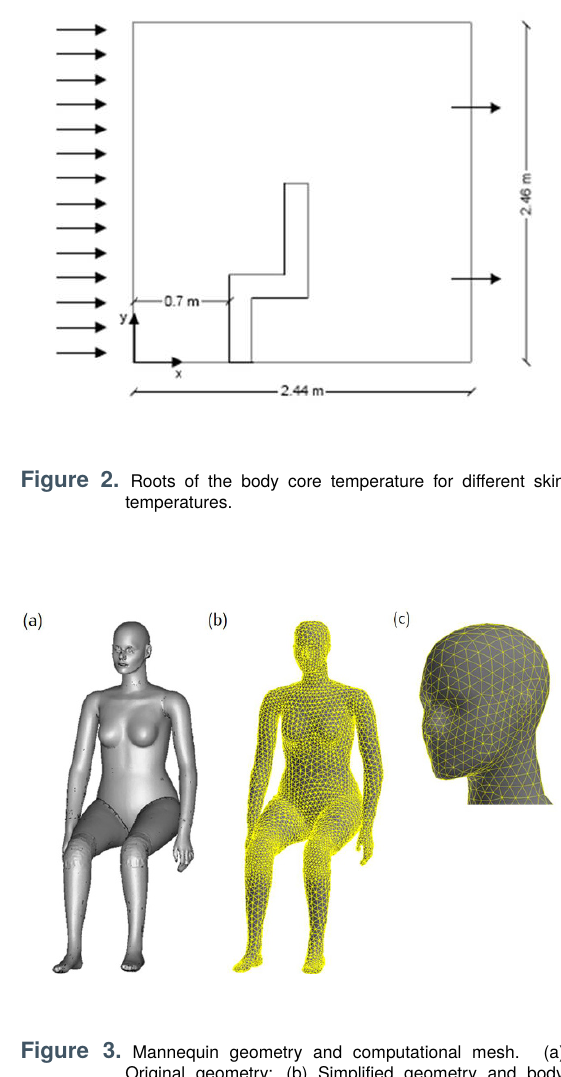
Figure 3. Mannequin geometry and computational mesh. (a) Original geometry; (b) Simplified geometry and body mesh; (c) Face